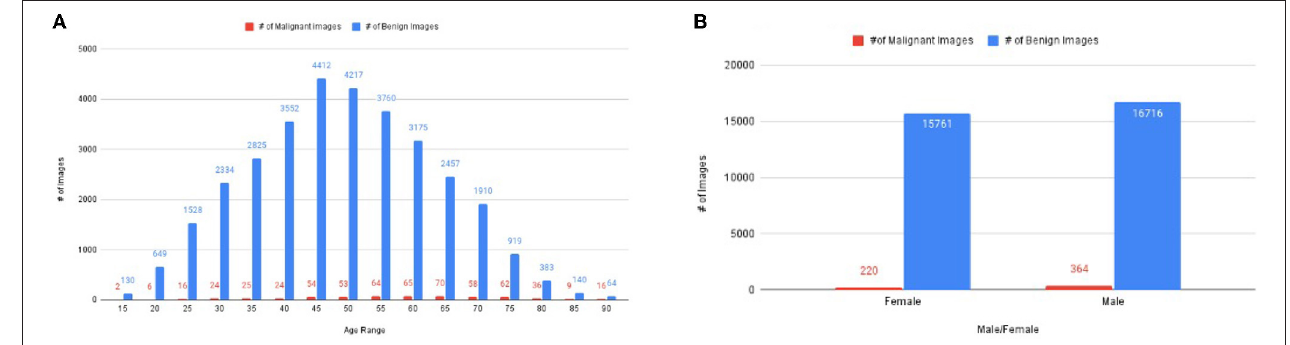
FIGURE 2 | The distribution of images, (A) number of images corresponding to age, (B) the number of images of malignant and benign corresponding to gender.